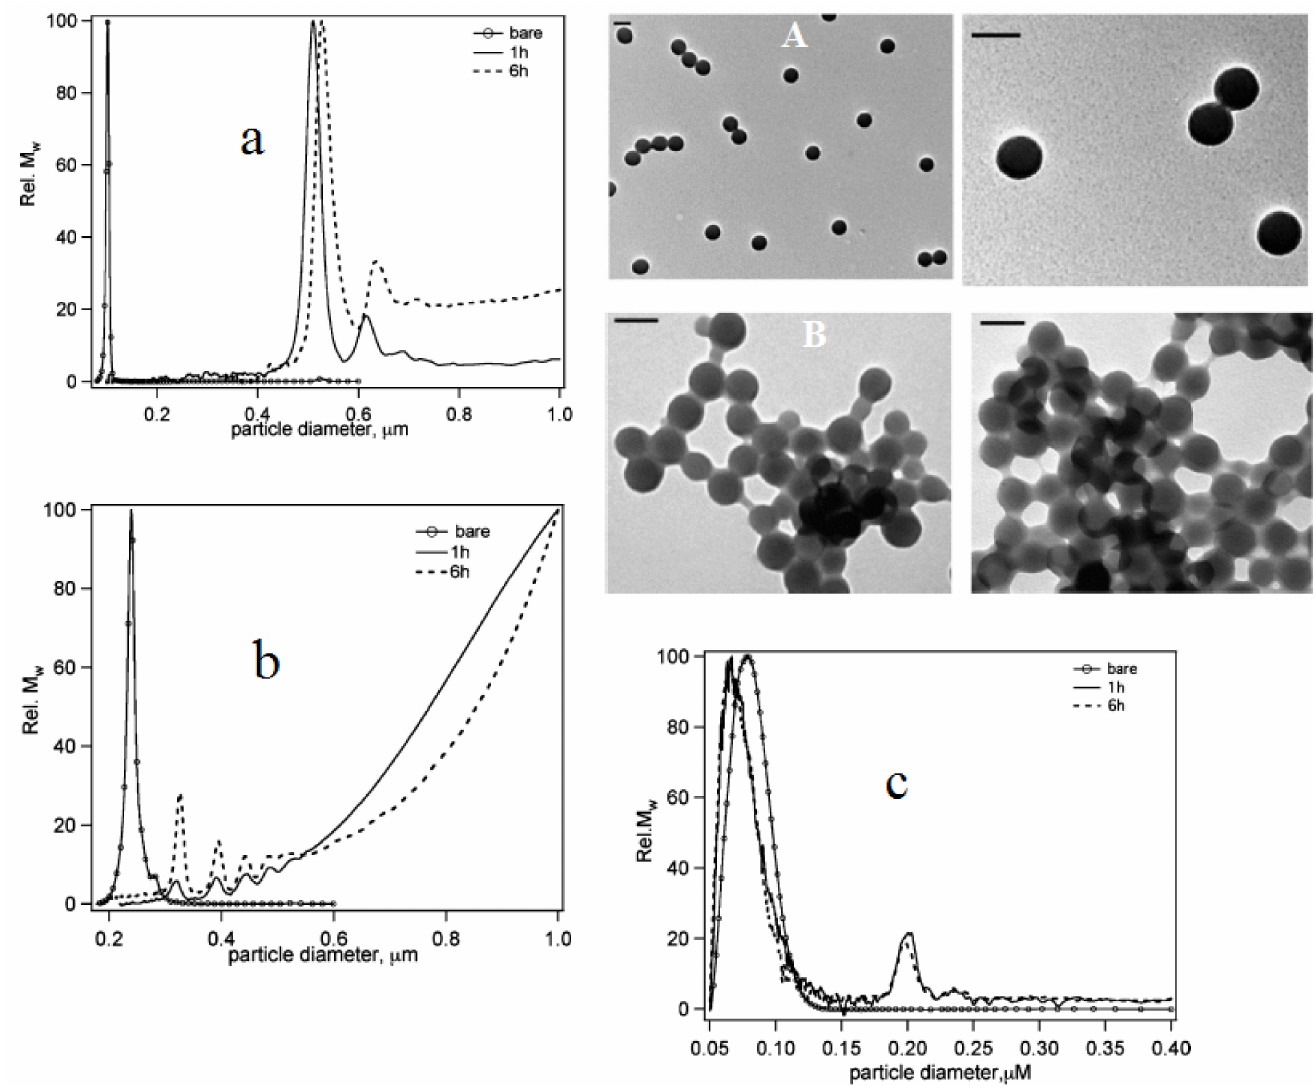
Figure 5. Time-resolved DCS experiments of 100 and 200 nm PSOSO 3 H and 50 nm SiO 2 NP–protein complexes. ( a ) DCS of 100 nm PSOSO 3 H NP–protein complexes free from excess plasma (washed system) as a function of time. ( b ) DCS of 200 nm PSOSO 3 HNP–protein complexes free from excess plasma. ( c ) DCS for 50 nm SiO 2 NP–protein complexes free from excess plasma. In all graphs, the bare NP results (open circles) are reported for reference. TEM images of bare 100 nm PSOSO 3 H NPs at different magnifications ( A ). TEM pictures of 100 nm PSOSO 3 H protein–NP complexes free from excess plasma ( B ). Bar = 100 nm. Adapted, with permission, from [19]. Copyright (2020) American Chemical